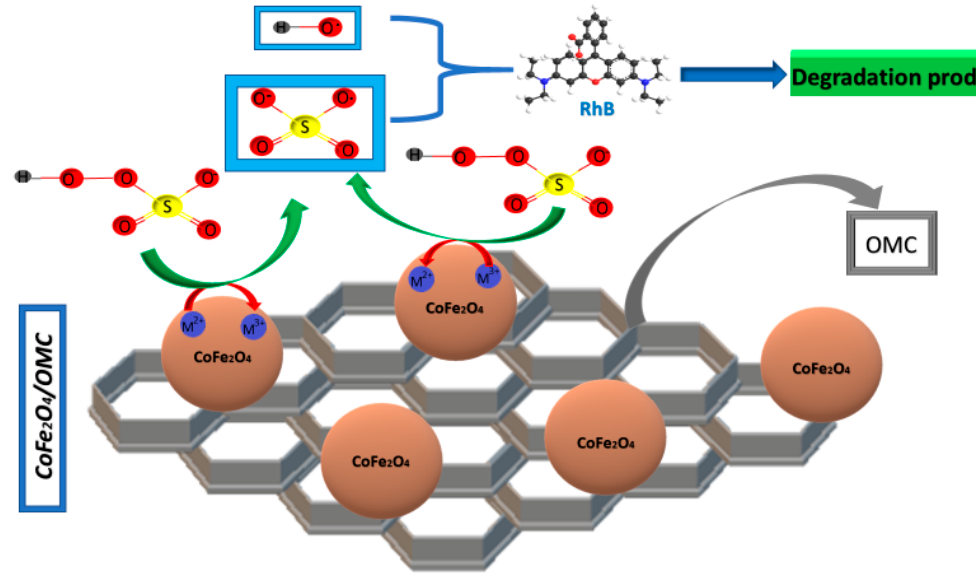
Figure 9. Mechanism for RhB degradation in CoFe 2 O 4 /OMC activated PMS system [106].